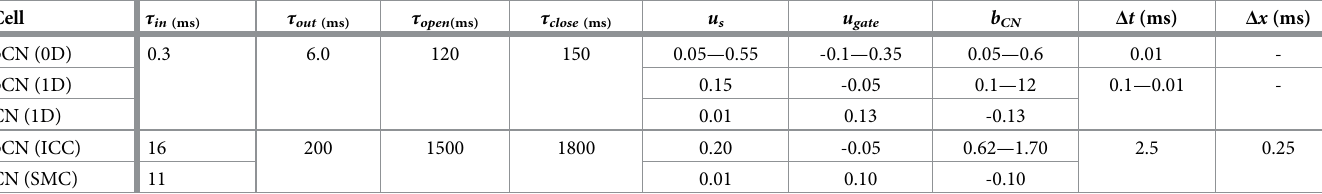
Table 3. Parameters for the pCN and CN models used in the 0D (isolated cell), 1D, and 3D simulations. Cell τ in (ms) τ out (ms) pCN (1D) 0.15 CN (1D)